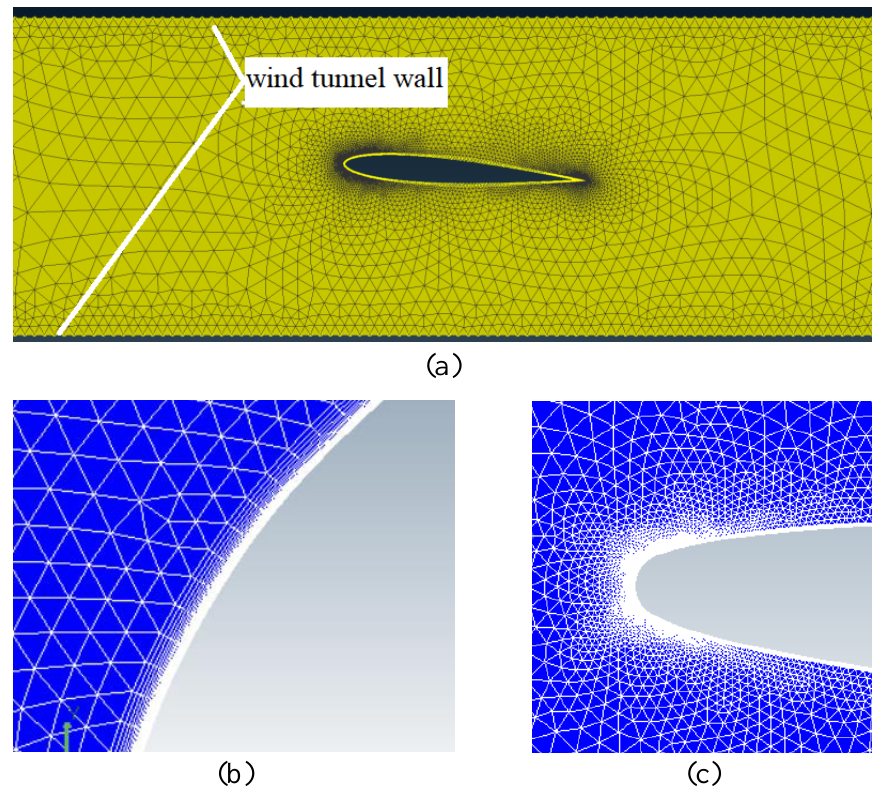
Figure 1. Model description and mesh configuration. ( a ) Sketch of the airfoil in a wind tunnel. ( b ) Boundary layer grids. ( c ) Grids near the edge of the airfoil.